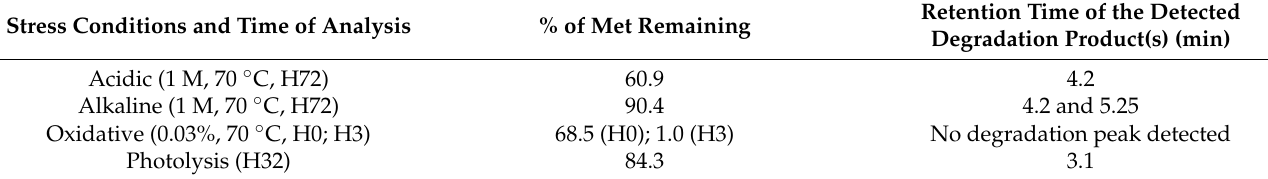
Table 4. Methionine Forced Degradation